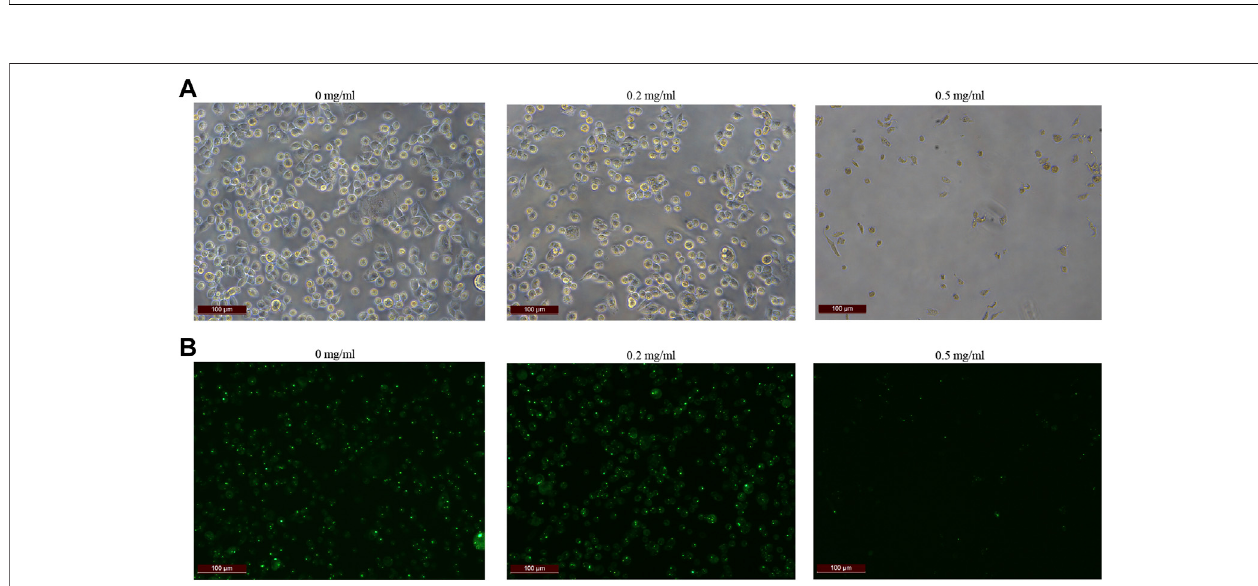
FIGURE 3 | The cell extension of CHO cells in vitro . (A) The cell extension results of CHO cells treated with tigecycline with the concentrations of 0 mg/ml, 0.2 mg/ ml, and 0.5 mg/ml. (B) Fluorescence microscopy was used to re fl ect cell viability, and we used cell staining to make cells appear green under fl uorescence, while dead cells were not. The fl uorescence color results of CHO cells treated with tigecycline with the concentrations of 0 mg/ml, 0.2 mg/ml, and 0.5 mg/ml.